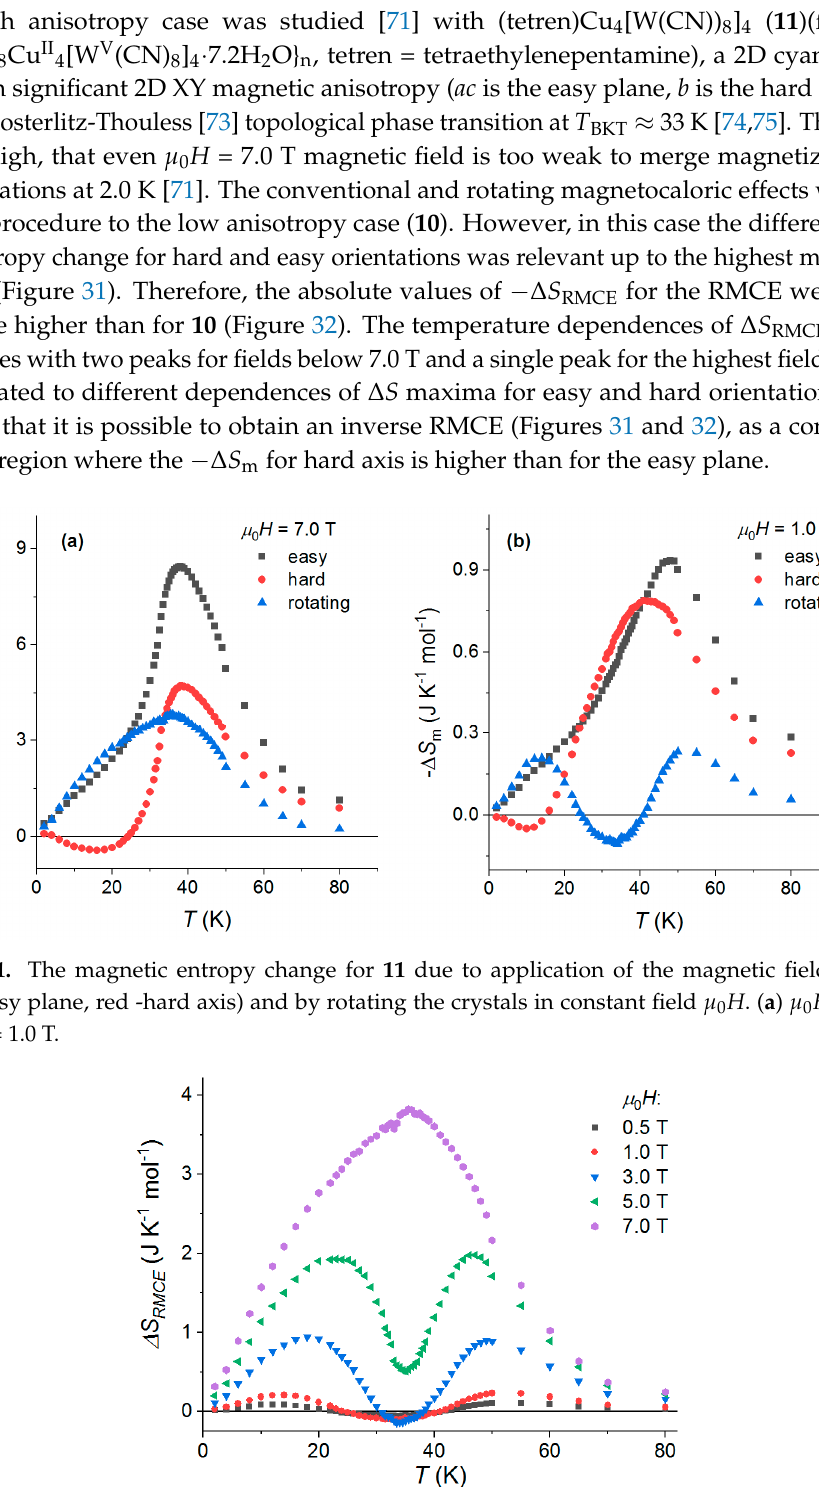
Figure 30. Temperature dependence of percentage ratio between Δ S RMCE and Δ S easy (easy plane) for 10 for different fields. Adapted with permission from Reference [72]. Copyright 2017 American Chemical Society.